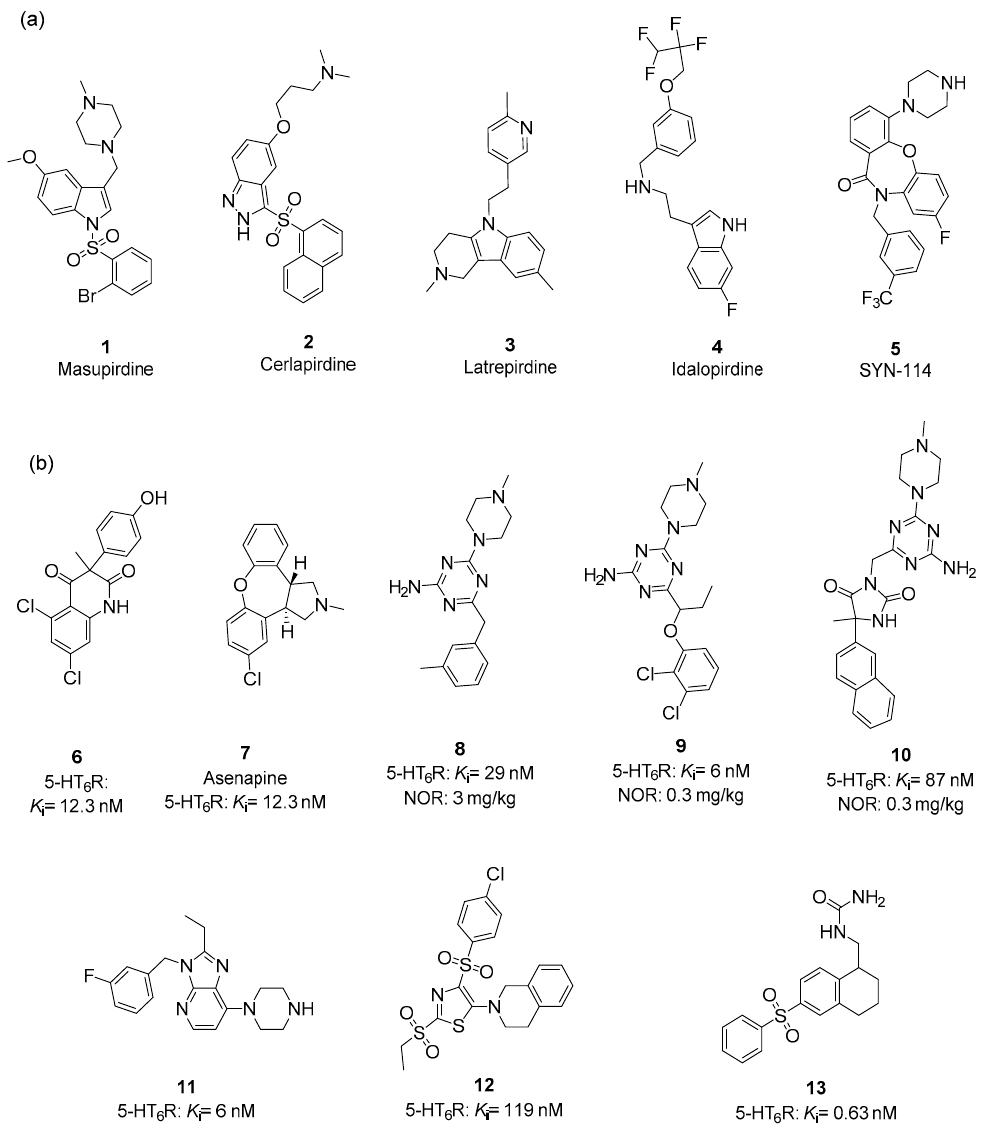
Figure 1. The structural variety of 5-HT 6 R antagonists: ( a ) compounds 1 [23,24], 2 [25], 3 [26–29], 4 [30–32] and 5 [33] investigated in clinical trials; ( b ) compounds in the early stages of R&D: the non-indole and non-sulfone derivatives 6 [34], 7 [35], 8 [36,37], 9 [38,39], 10 [40,41]and 11 [42] and non- basic antagonists 12 [43] and 13 [43,44]. The affinity for 5-HT 6 R expressed with K i (nM). Procognitive effects in the Novel Object Recognition (NOR) test for 8–10 . at the dose shown